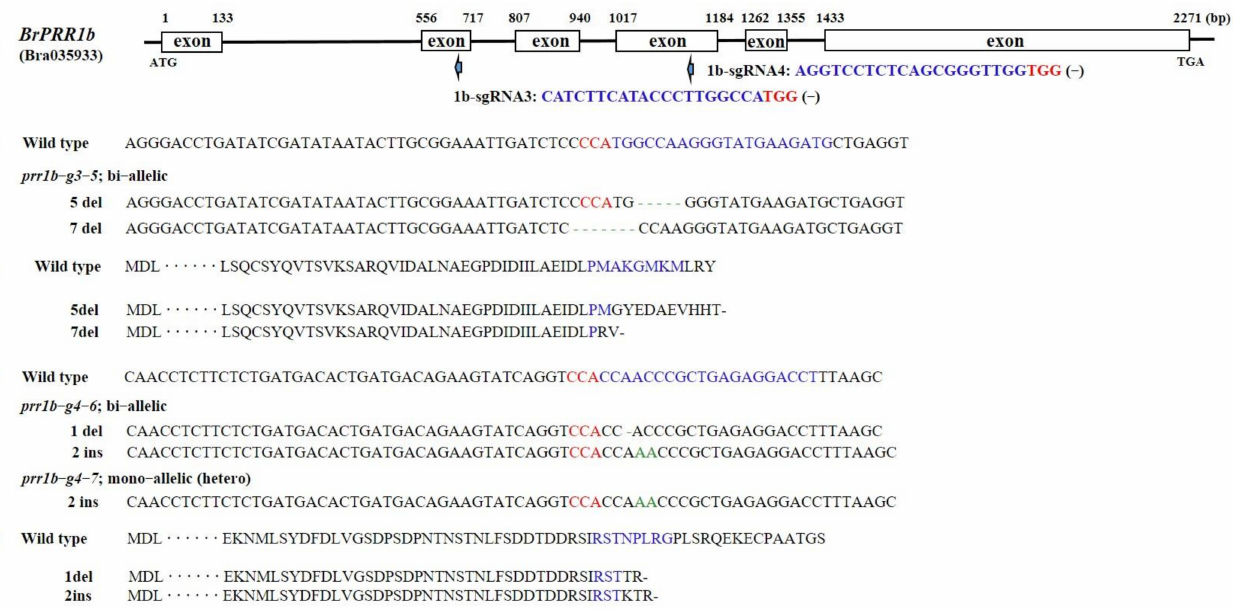
Figure 3. Genome editing of the Chinese cabbage BrPRR1b gene. Design of sgRNA sites for BrPRR1b exons. The PAM motif (NGG) is shown in red ( A ). NGS alignment of the sgRNA target region in different mutant lines. Deletions and insertions are indicated by dashes and green letters, respectively ( B , D ). Amino acid sequences of wildtype and generated mutations are shown ( C , E ). The sgRNA and PAM sites are represented in blue and red. Stop codon is shown with black